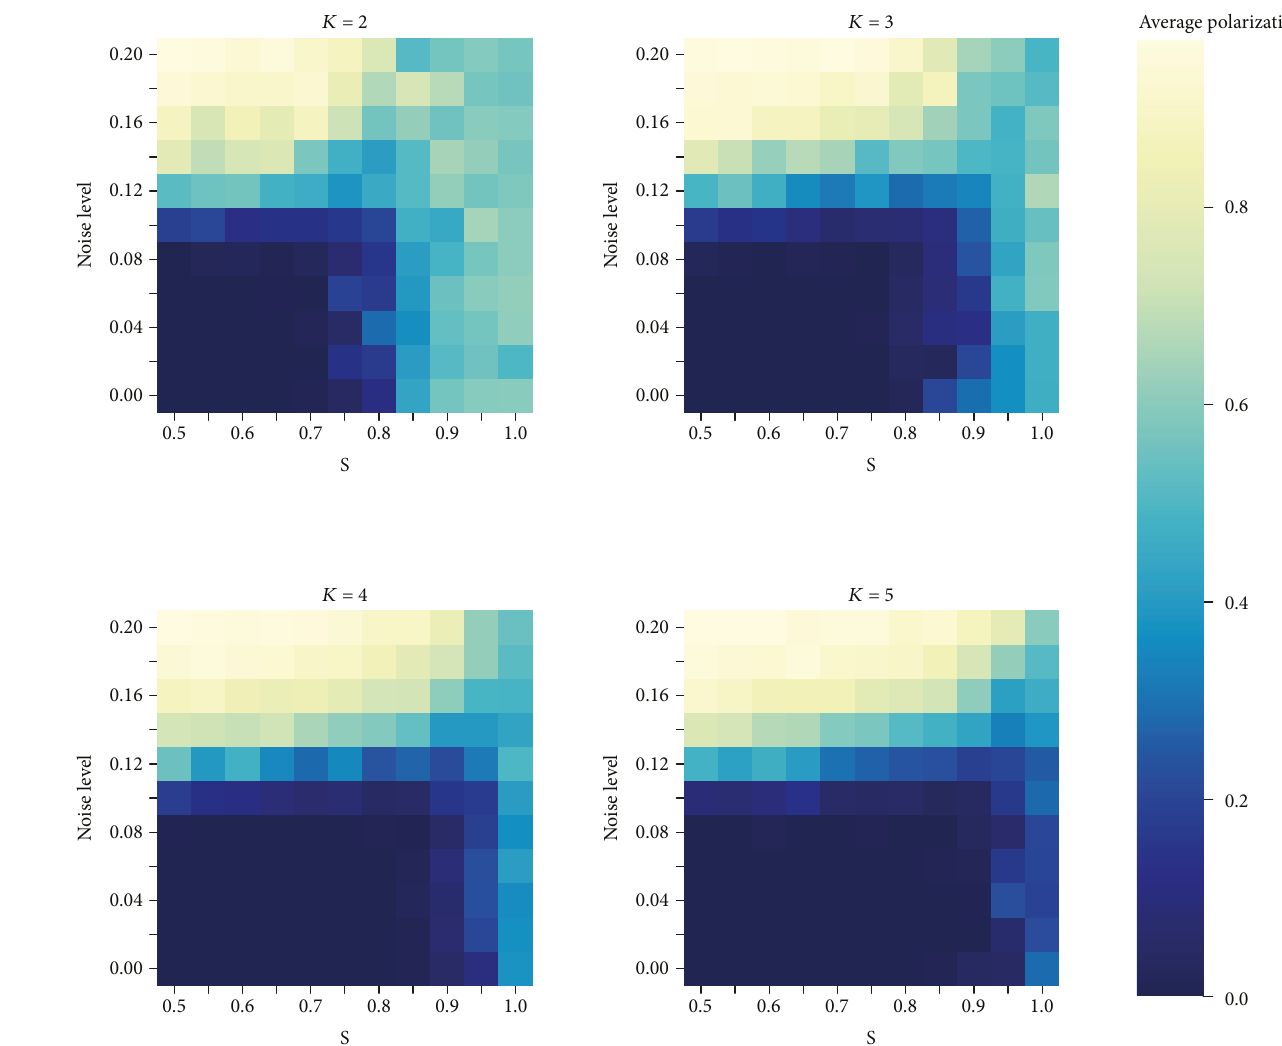
Figure 11: Final average polarization varies with both the width of the uniform distribution of initial opinion magnitudes and the noise level in the opinion updates. The value in each square of the heat map is the average of 100